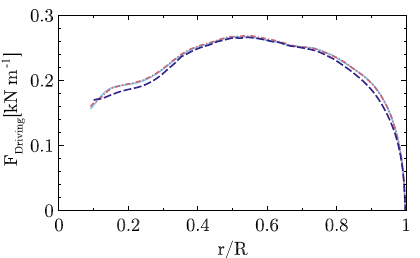
Figure B3. Influence of boundary layer transition on the sectional driving force. Fully turbulent k – ω –SST (dashed), γ – Re θ – k – ω –SST (solid), e N – k – ω –SST (dashed